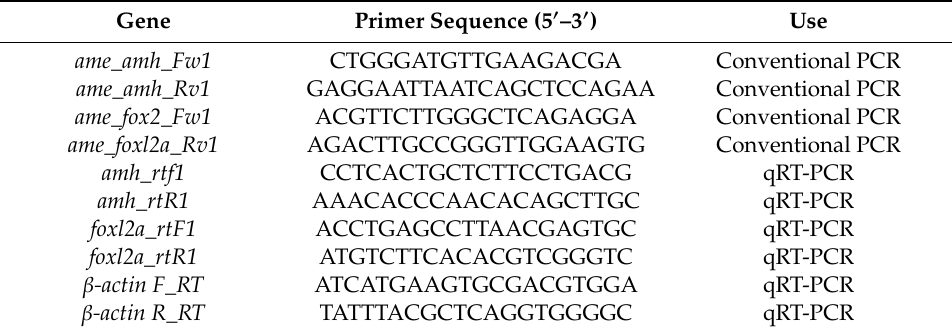
Table 1. Designed primers used for conventional PCR and